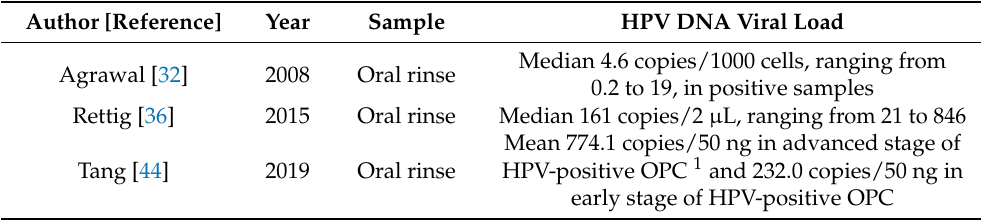
Table 4. HPV DNA viral load in pre-treatment oral rinse in oropharyngeal cancer